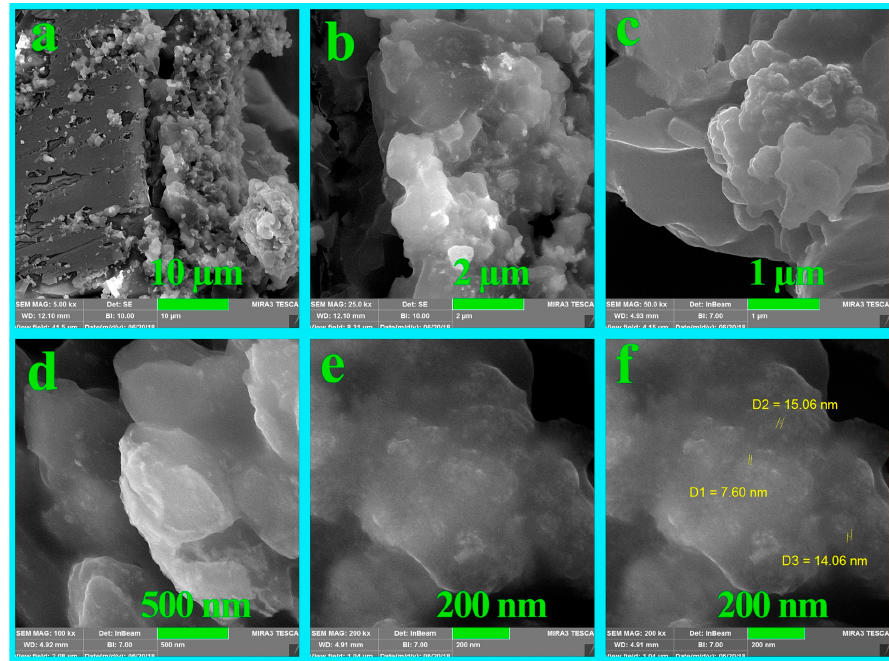
Figure 10. FE-SEM micrographs of NC 4.